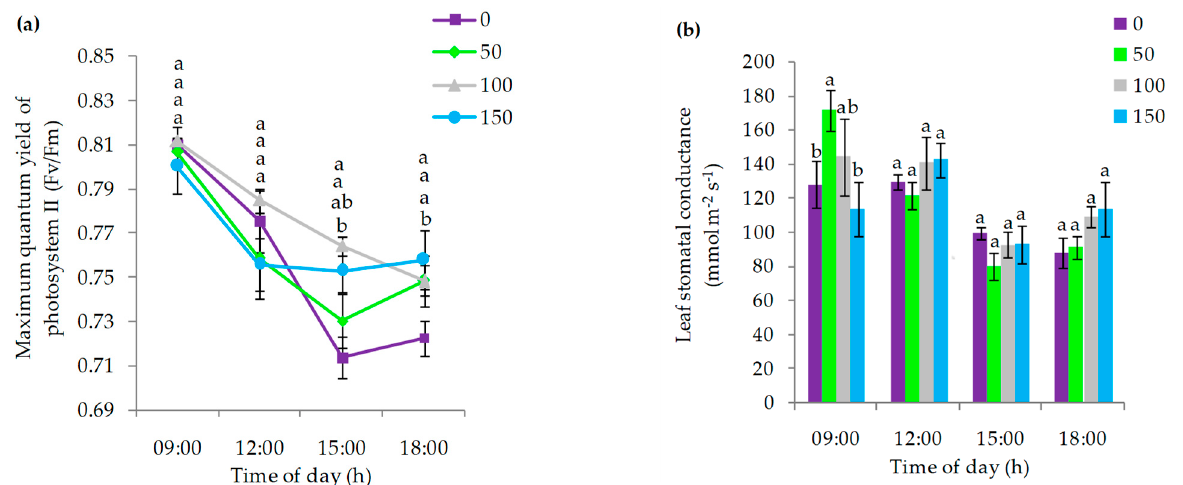
Figure 4. ( a ) Variation of the maximum quantum yield of photosystem II (F v /F m ) in calafate plants; ( b ) Values recorded for stomatal conductance (mmol m − 2 s − 1 ), in calafate plants subjected to different doses of water replenishment, evaluated at different times of the day: 09:00, 12:00, 15:00 and 18:00 h. Treatments: 0%, 50%, 100% and 150% ET 0. Different lowercase letters indicate significant differences between treatments according to Fischer’s LSD test ( p < 0.05). Mean ± standard error ( n = 4). Bars correspond to experimental error for each treatment.